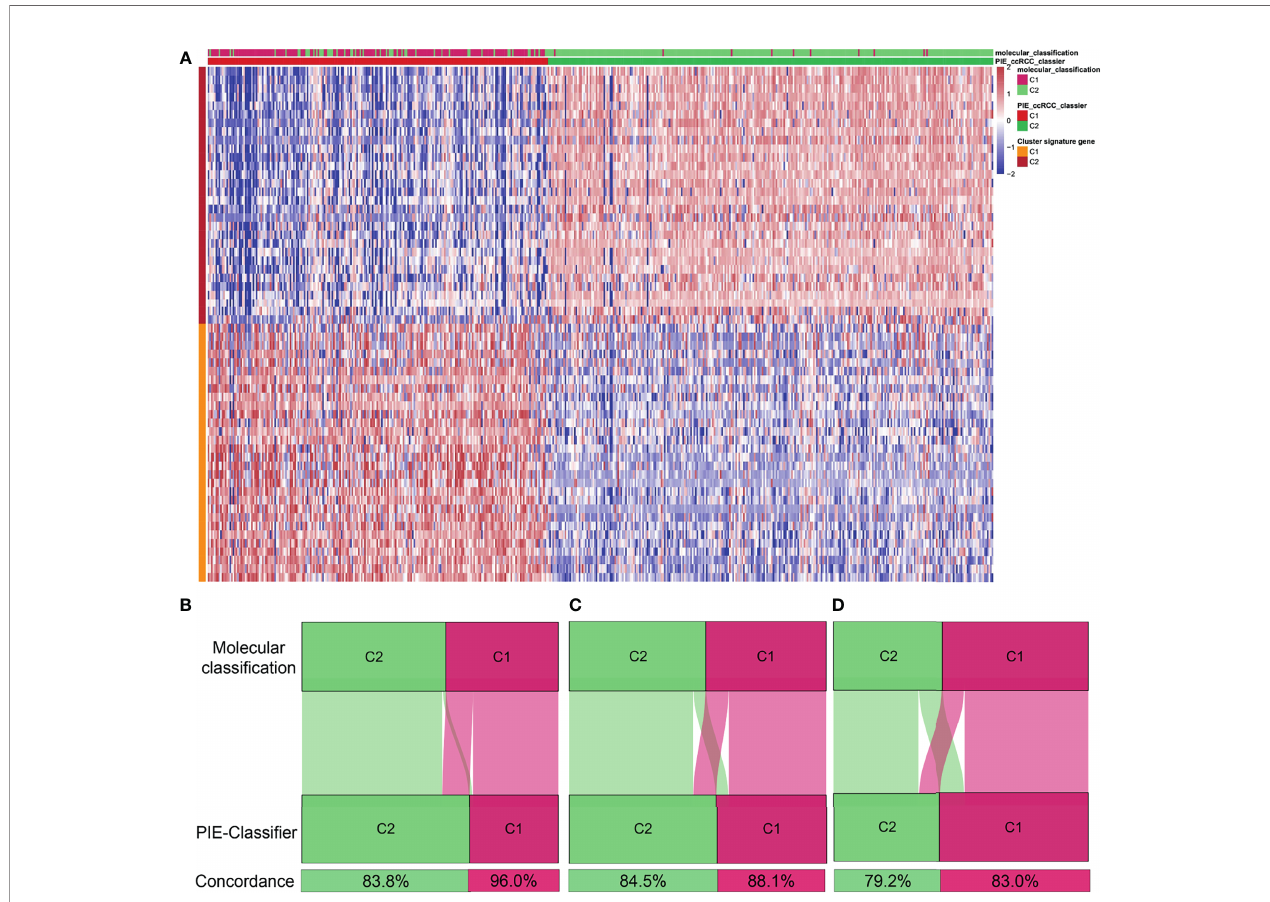
FIGURE 7 | Identi fi cation of a simple gene classi fi er. (A) Heatmap of the expression level of the PIE classi fi er (PIE classi fi er: prognosis and ICB therapeutic ef fi cacy of the ccRCC classi fi er). Concordance of molecular clusters prediction in TCGA (B) , E-MTAB-1980 (C) Check-mate 025 (D) cohorts between the PIE classi fi er and molecular classi fi cation based on CNMF